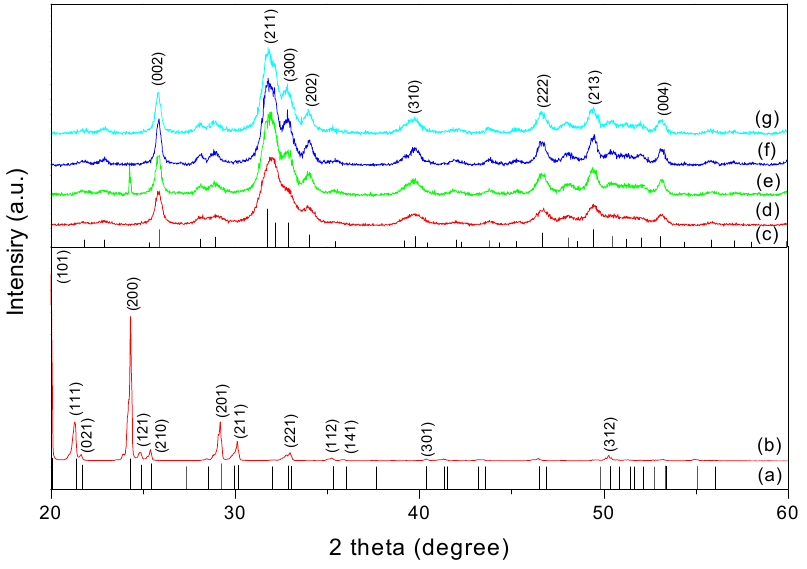
Figure 5. XRPD diffractograms of ( a ) 4AP ‐ JSPDC No. 030 ‐ 1518, ( b ) 4AP, ( c ) HAP ‐ JSPDC No. 009 ‐ 0432, ( d ) HAP, ( e ) HAP_4AP_25, ( f ) Si – HAP, and ( g ) Si – HAP_4AP_25,